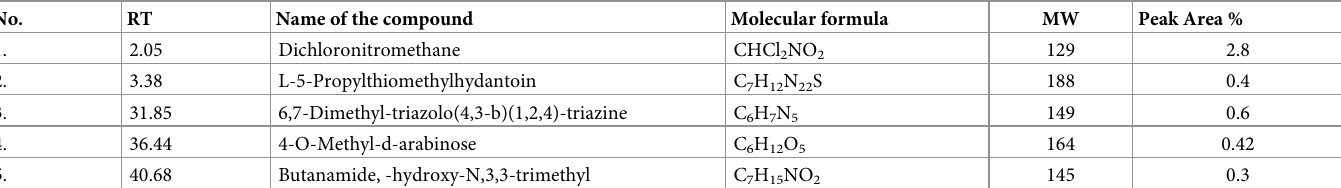
Table 4. Compounds identified from band-D of EA fraction of AE1 by GC-MS analysis.